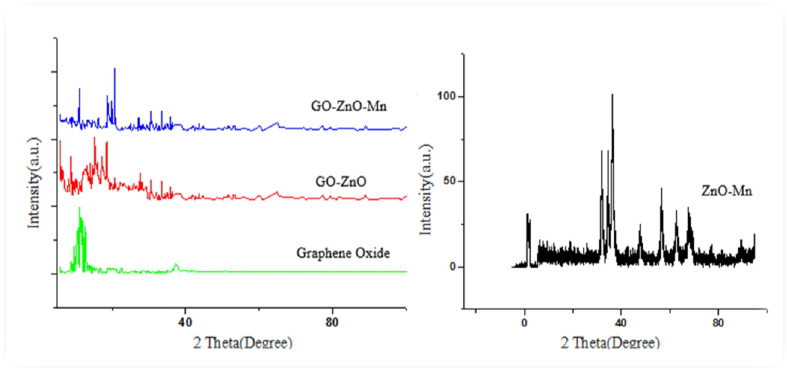
Fig. 4. XRD Patterns of GO, GO-ZnO, and GO-ZnO-Mn Nanocomposites